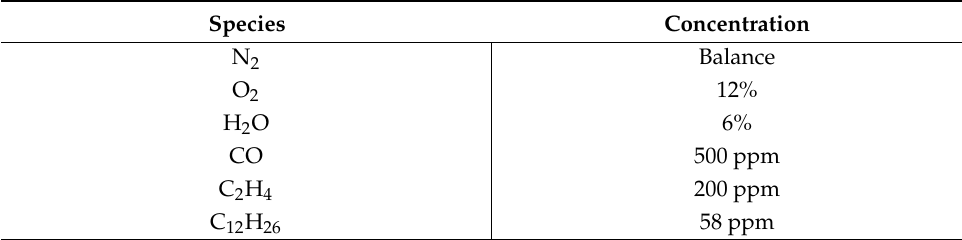
Table 2. Feed gas concentration for each species.